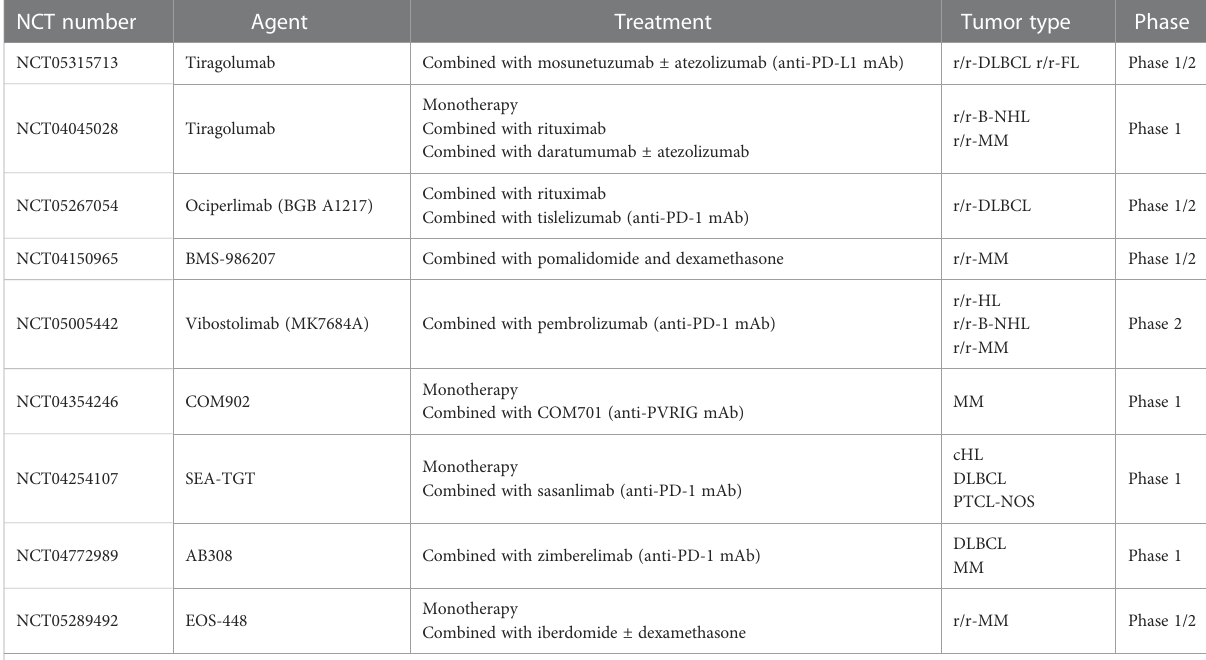
TABLE 1 Ongoing clinical trials targeting TIGIT in hematological malignancies. NCT